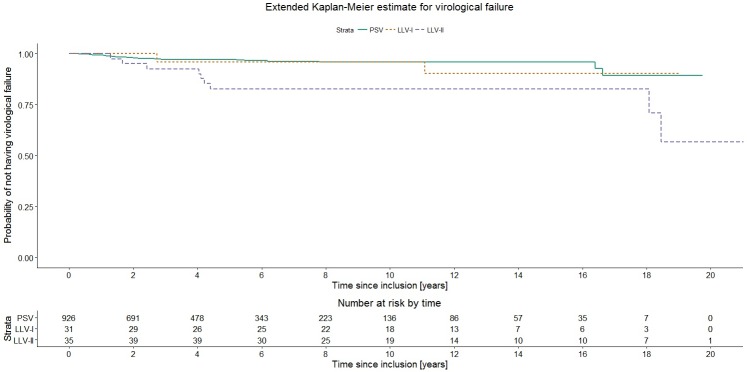
Extended Kaplan-Meier estimate for virological failure, stratified by viremia category (n = 992).Abbreviations: PSV–permanently suppressed viremia; LLV-I–low-level viremia 50–199 copies/mL; LLV-II–low-level viremia 200–999 copies/mL; HLV–high-level viremia.